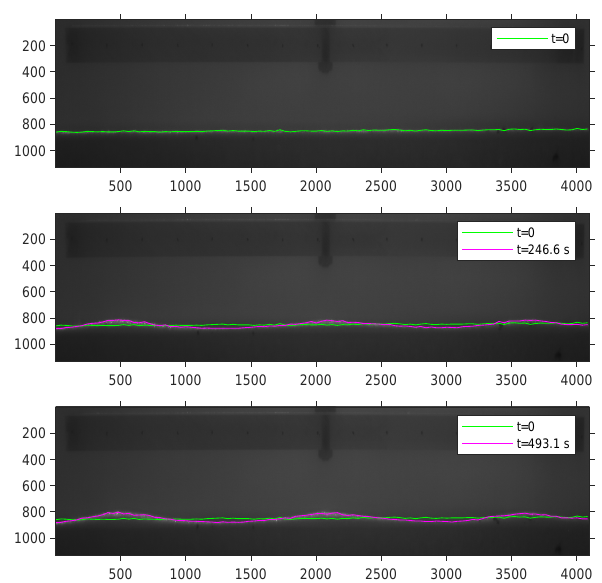
Fig. 3 : Run n.70, both the axes are in pixel (where 1300 pixels correspond to 10 cm ).